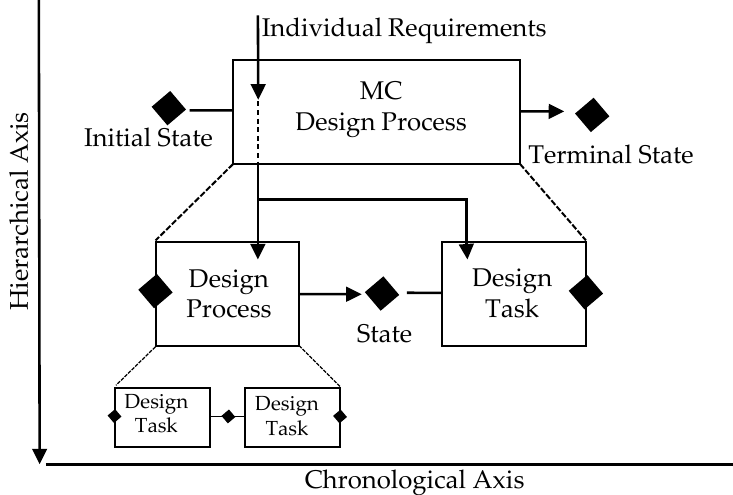
Figure 3. Illustration of a hypothetical MC Design Process with three